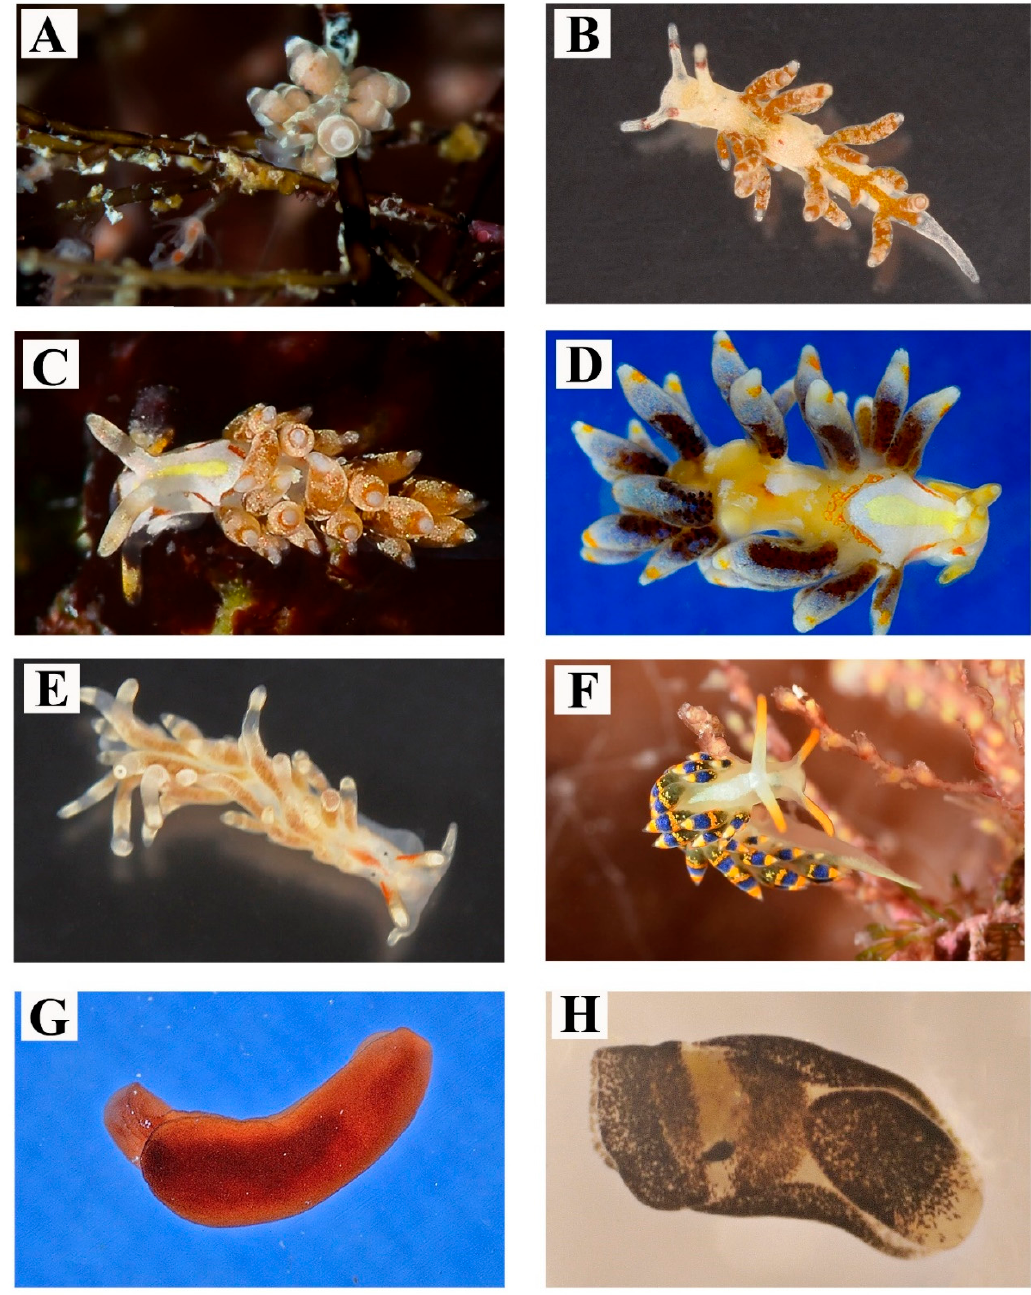
Figure 6. ( A ) Catriona maua . St. 9 ( B ) Rubramoena amoena . St. 22 ( C ) Trinchesia genovae . St. 11 Figure 6. A. Catriona maua . St. 9 B. Rubramoena amoena . St. 22 C. Trinchesia genovae. St. 11 D. Trinchesia ( D ) Trinchesia genovae . St. 7 ( E ) Trinchesia cf. miniostriata St. 22 ( F ) Trinchesia morrowae . St. 11 ( G ) Runcina genovae. St. 7 E. Trinchesia cf. miniostriata St. 22 F. Trinchesia morrowae . St. 11 G. Runcina cf. ferruginea. cf. ferruginea . St. 22 ( H ) Philine punctata St. St. 22 H. Philine punctata St. 9.